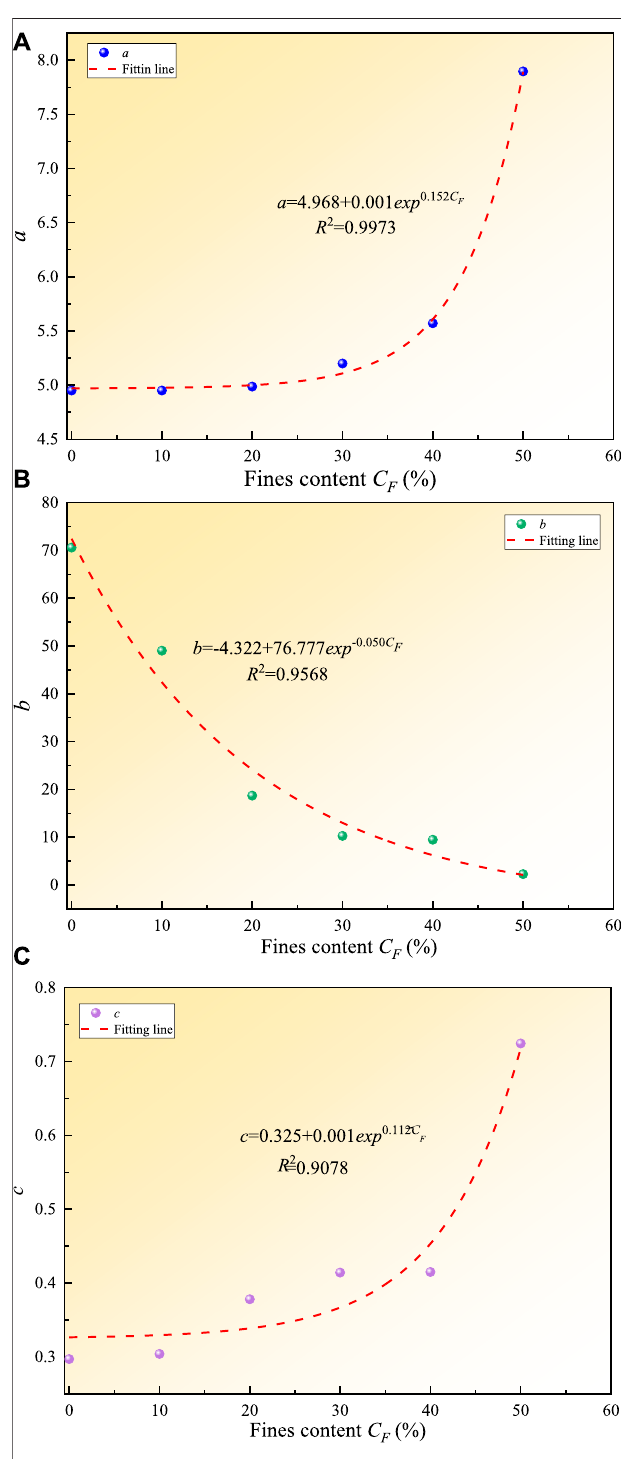
FIGURE 8 | Relationship between simulation parameters of SWCC and fi nes content: (A) a versus C F ; (B) b versus C F ; (C) c versus C F